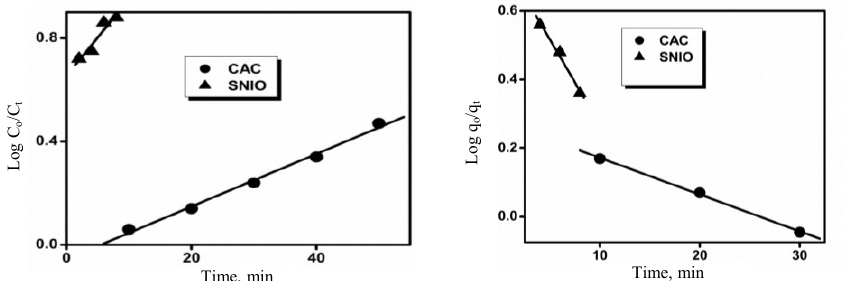
Figure 8. Natarajan and Khalaf and Legergren equation for the removal of Ni(II) ion by CAC and SNIO at different time interval.